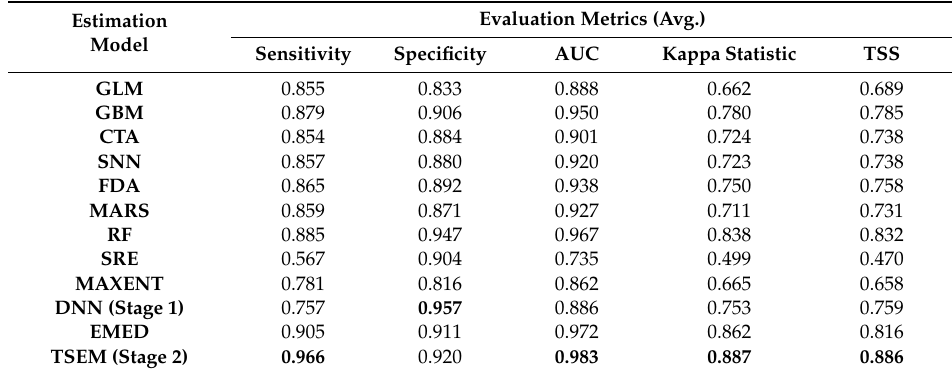
Table 7. Evaluation criteria of AUC, kappa statistic and TSS. Table 6. Performance comparison of estimation models.